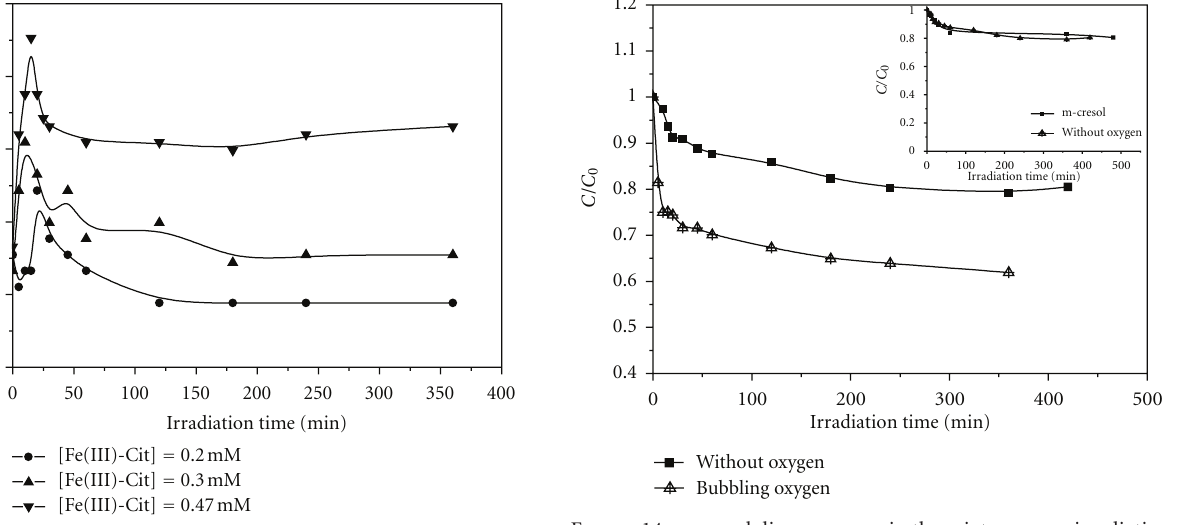
Figure 12: Fe(II) formation during m-cresol photodegradation (0.1mM) in the presence of di ff erent complex concentrations. λ = 365nm: • [Fe(III)-Cit] = 0.2 mM, (cid:3) [Fe(III)-Cit] = irradiation